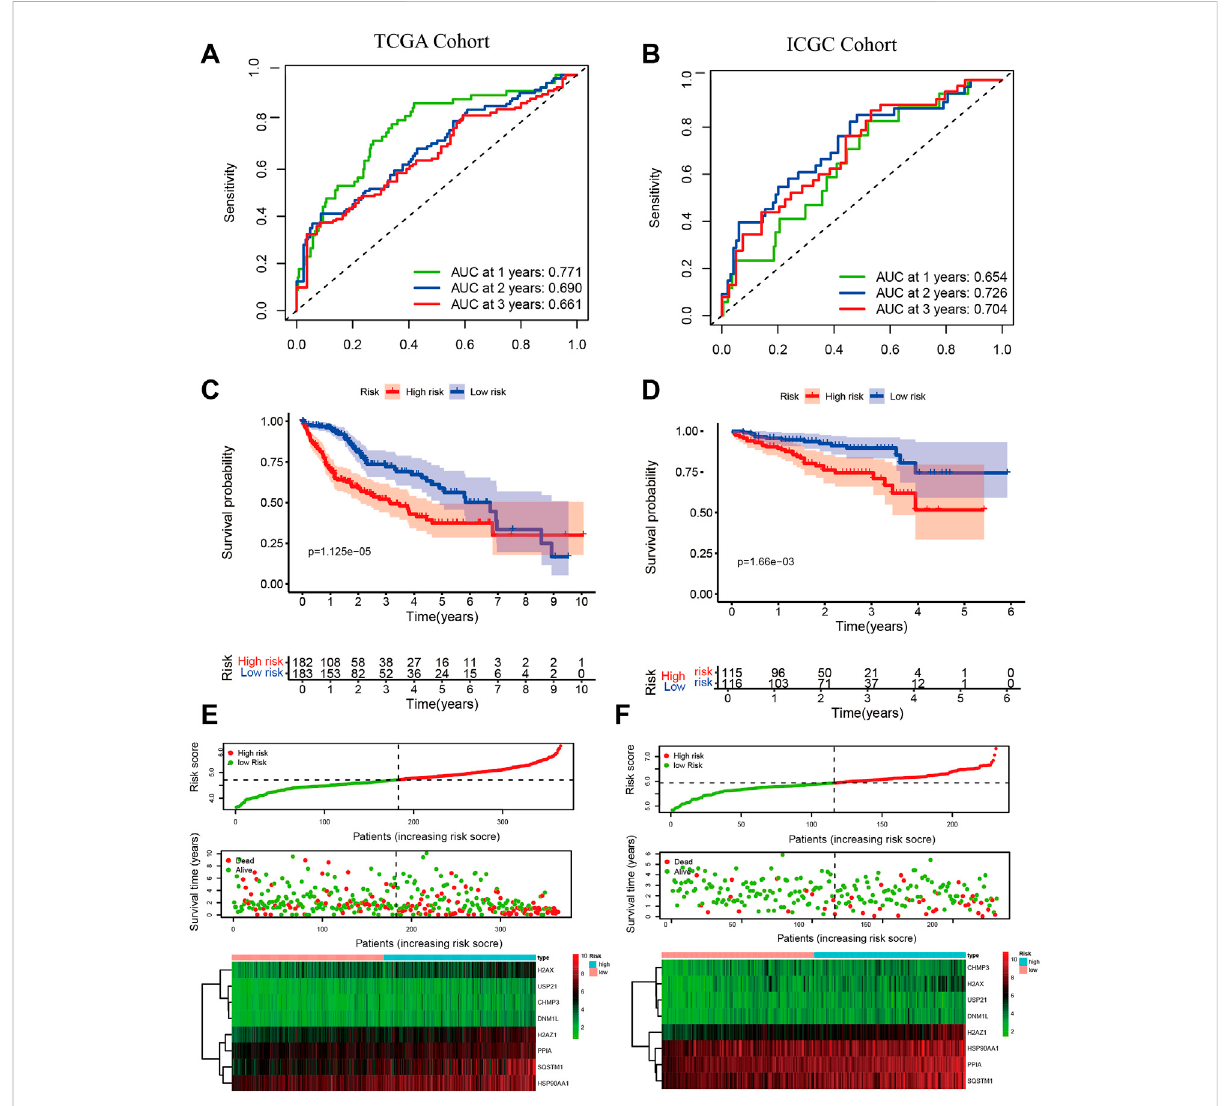
FIGURE 4 Validationofrisksignature.Time-dependentROCforpredicting1-,2-,and3-yearsOSintheTCGAcohort (A) andtheICGCcohort (B) ;Kaplan- Meier survival curves show different OS between high- and low-group in TCGA (C) and ICGC (D) ; The risk score, survival status, and the heatmap of 8 NRGs between high- and low-group in TCGA (E) and ICGC (F) . Independent prognostic indicator and nomogram